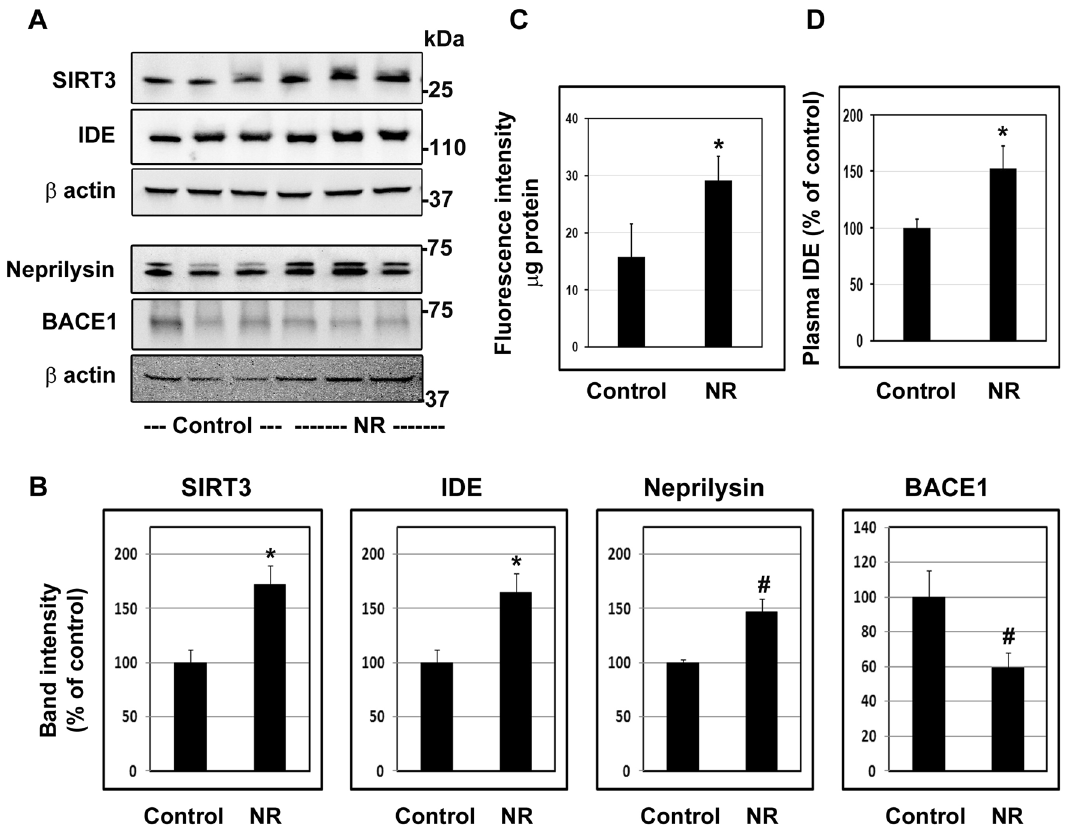
Figure 6. In vivo effects of SIRT3 activation by NR. Seven-month-old C57BL/6 male mice (WT, 6/group) were fed regular chow or diet supplemented with NR (0.4% W/W) for 3 months. The mice were sacrificed, and cortical samples and blood were collected. Western blot analysis was performed to determine the levels of SIRT3, IDE, neprilysin and BACE1 ( A ). Representative cropped images are presented for clarity and conciseness while the composite color images of full blots are presented in Supplementary Figure. The band intensities were measured by scanning and corrected for the levels of β actin. ( B ). IDE activity was measured with the cortical samples by a fluorometric assay. The activities were expressed as fluorescence units per µg protein ( C ). Plasma was separated from the blood samples and IDE levels were determined by ELISA ( D ). Mean ± SE of 6 samples are presented. #, P < 0.05; *, P < 0.01; **, P < 0.001 compared to Control untreated mice. NR, nicotinamide